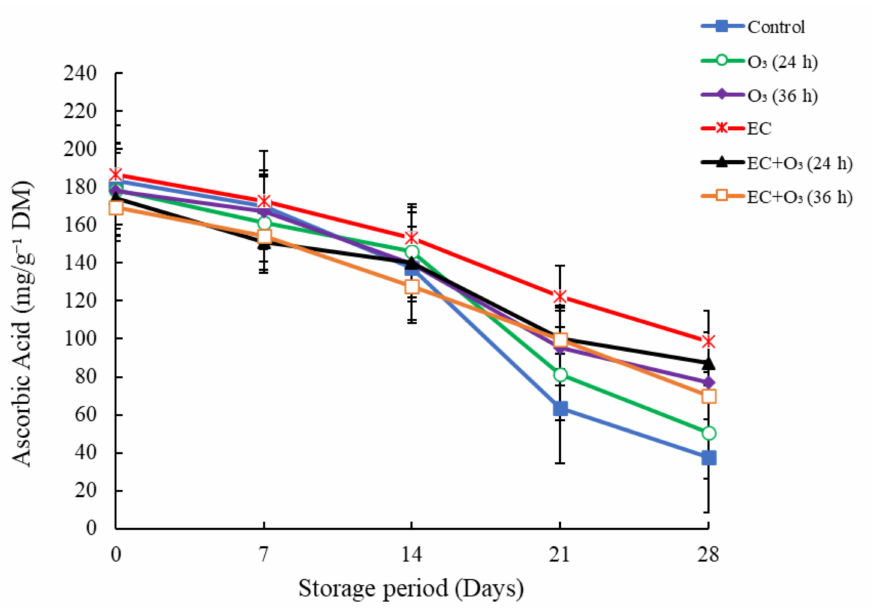
Figure 5. Effect of edible coating (EC) and gaseous ozone (O 3 ) on AA in mango fruit during storage for twenty-one days at 10 ◦ C and shelf-life for seven days at ambient temperature ( ± SE, n = 9).